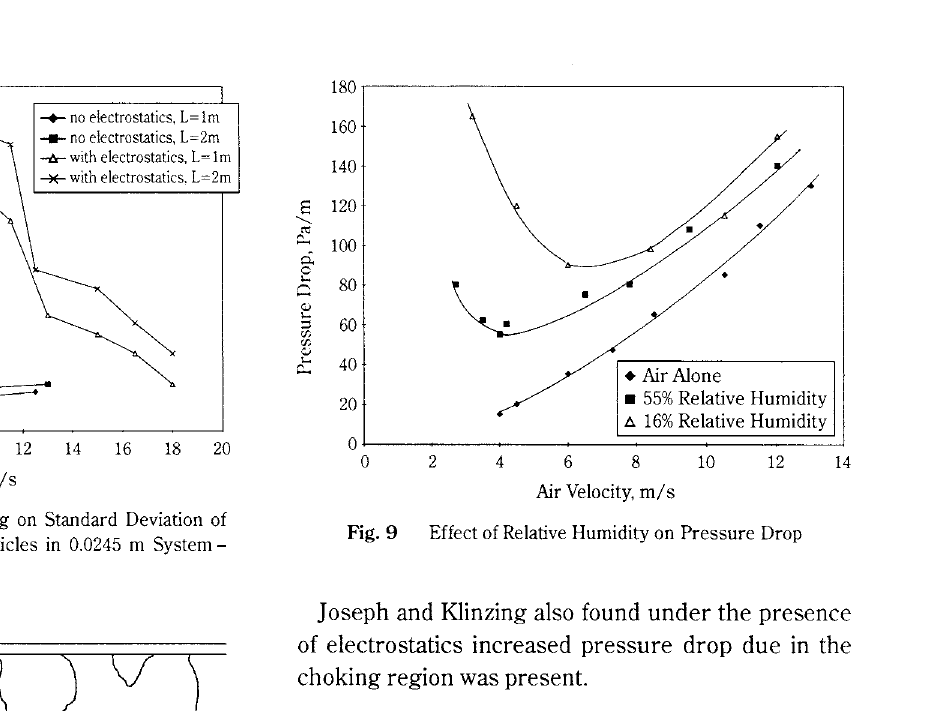
Effect of Electrostic Charging on Standard Deviation of Pressure Drop for PVC Particles in 0.0245 m System Ws=l.l4 kg/min